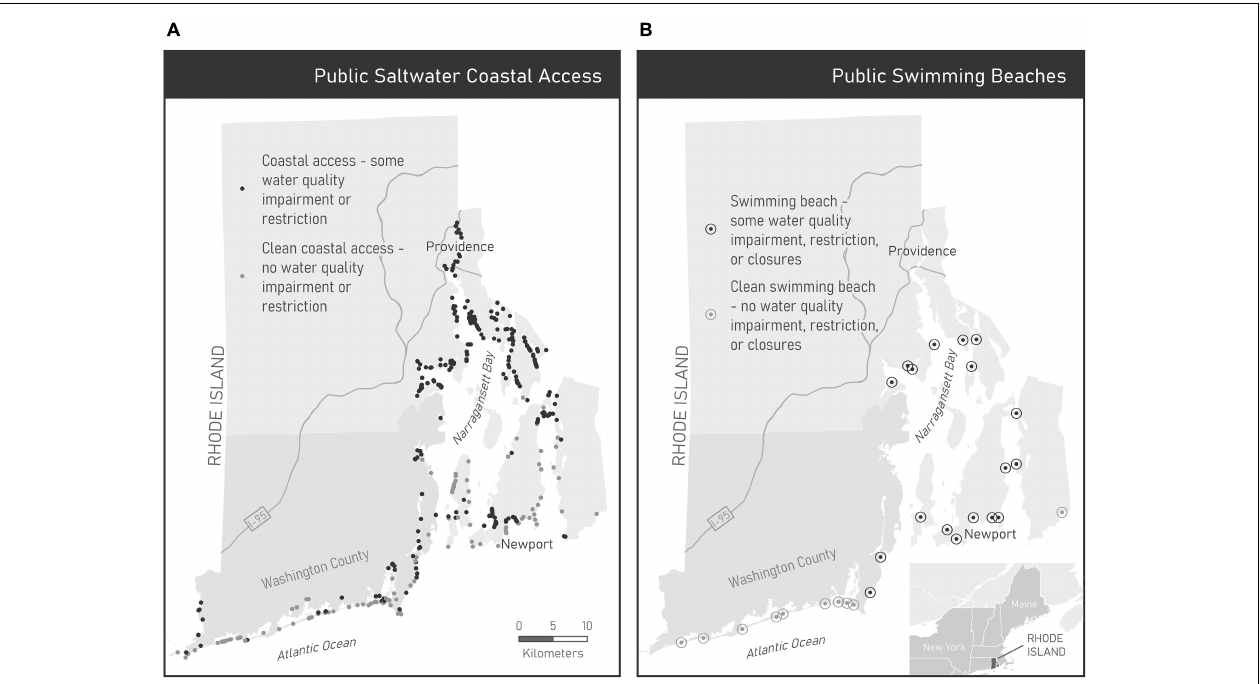
( Table 1 ). Road network travel distances for all possible origin- destination pairs were calculated using ESRI ArcGIS Online Connect Origins to Destinations (Esri, last accessed October 2019). The use of a distance-based approach in environmental